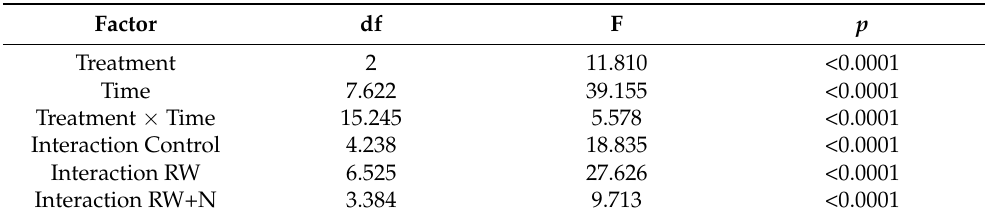
Table 1. Repeated measures ANOVA analyses for all treatments during phase 1 of our experiment. Control = watering every day, RW = Reduced watering (twice per week) and RW+N = Reduced watering (twice per week) and nitrogen addition. df: degrees of freedom, F: F-value, p : p -value. Factor df F p Treatment 2 11.810 <0.0001 Time 7.622 39.155 <0.0001 Treatment × Time 15.245 5.578 <0.0001 Interaction Control 4.238 18.835 <0.0001 Interaction RW 6.525 27.626 <0.0001 Interaction RW+N 3.384 9.713 <0.0001